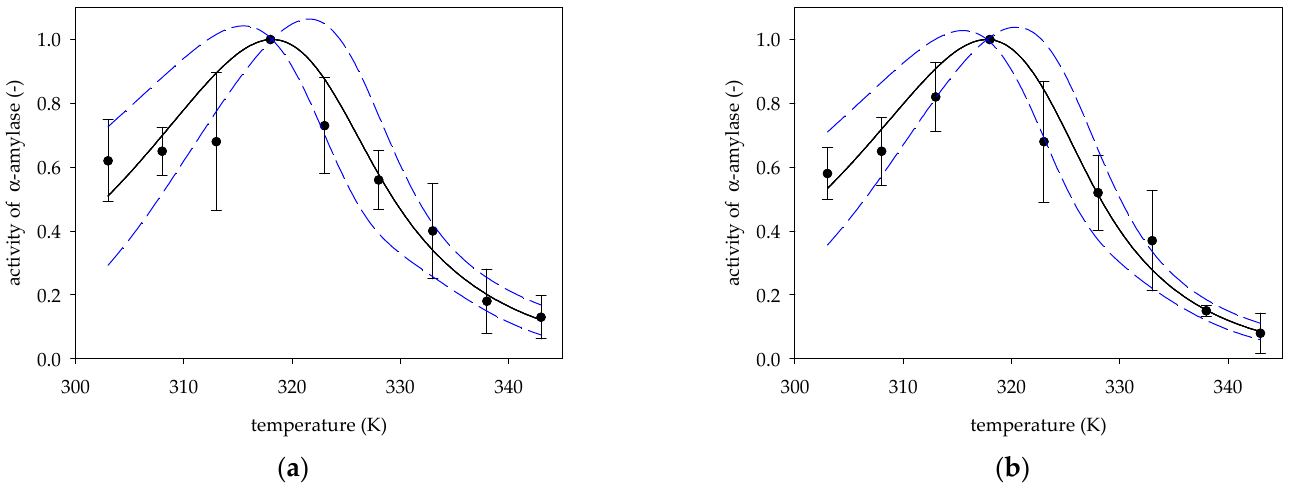
Figure 2. The activity of α -amylase porcine pancreas by measurements Gopal et al. [15]: ( a ) isoform I; ( b ) isoform II; ( ● )